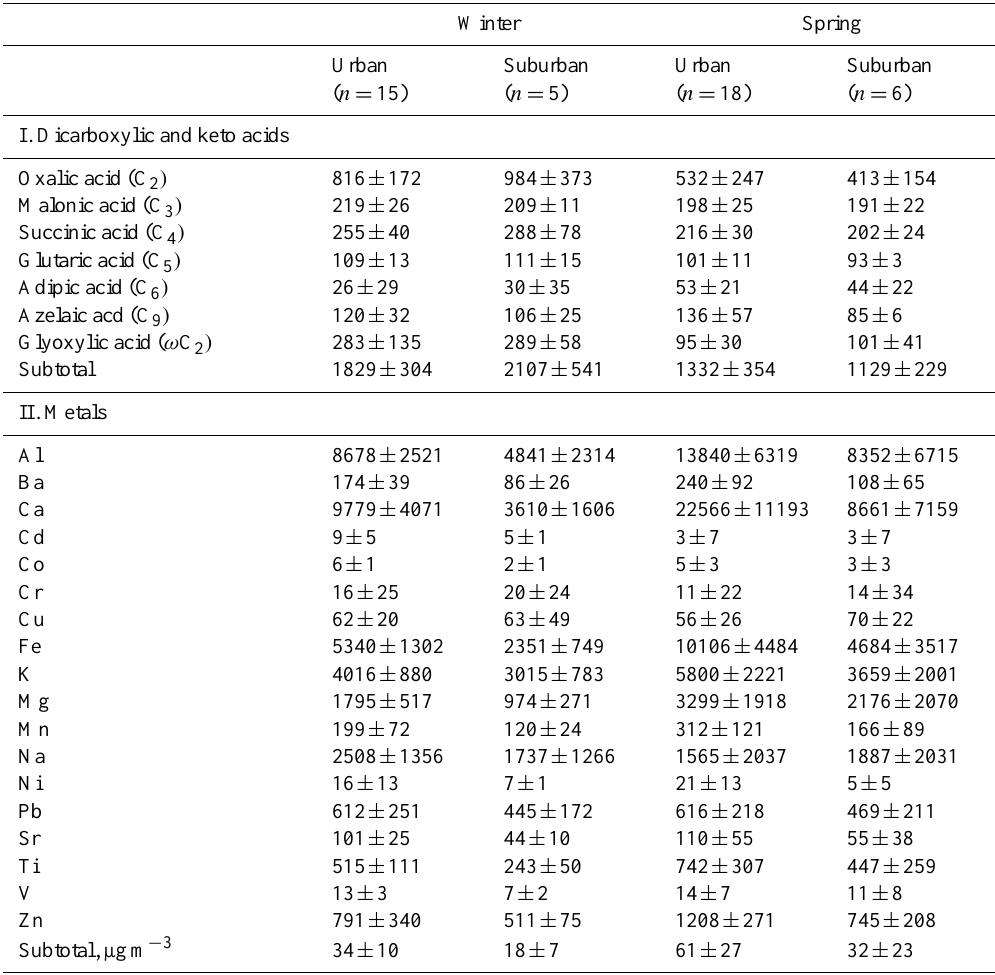
Table 2. Concentrations of dicarboxylic and keto acids and metals in PM 10 of Boaji city, ngm − 3 .